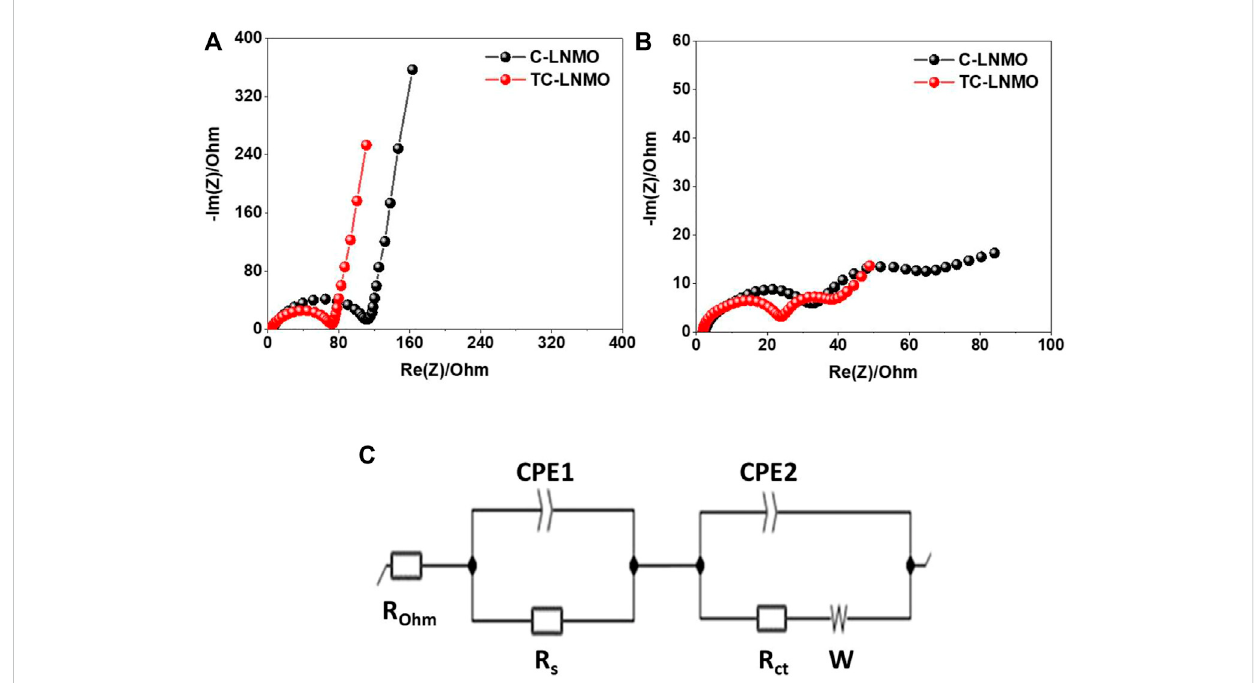
FIGURE 8 EIS spectra of the assembled coin cell recorded over the 100 mHz − 1 MHz range (A) before cycling (B) after cycling (C) an equivalent circuit model.